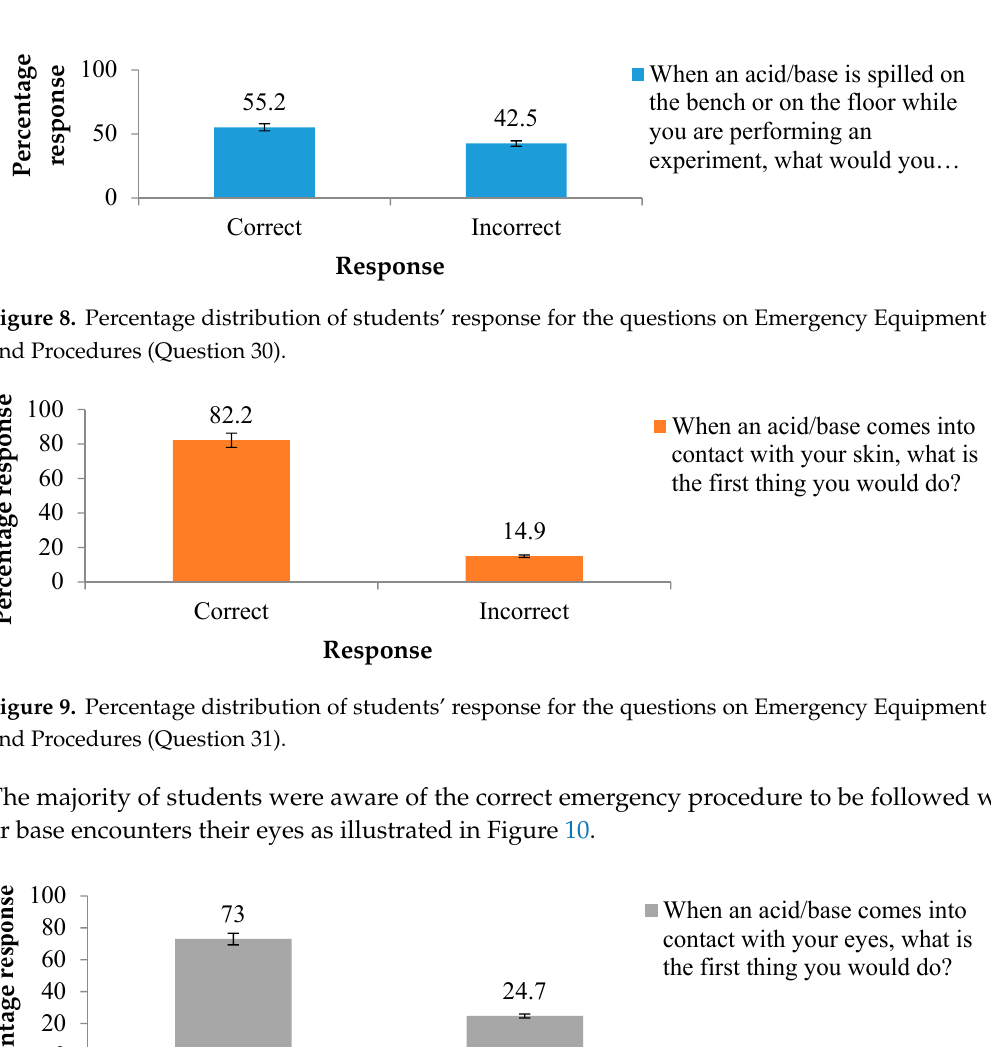
Figure 9. Percentage distribution of students’ response for the questions on Emergency Equipment and Procedures (Question 31).